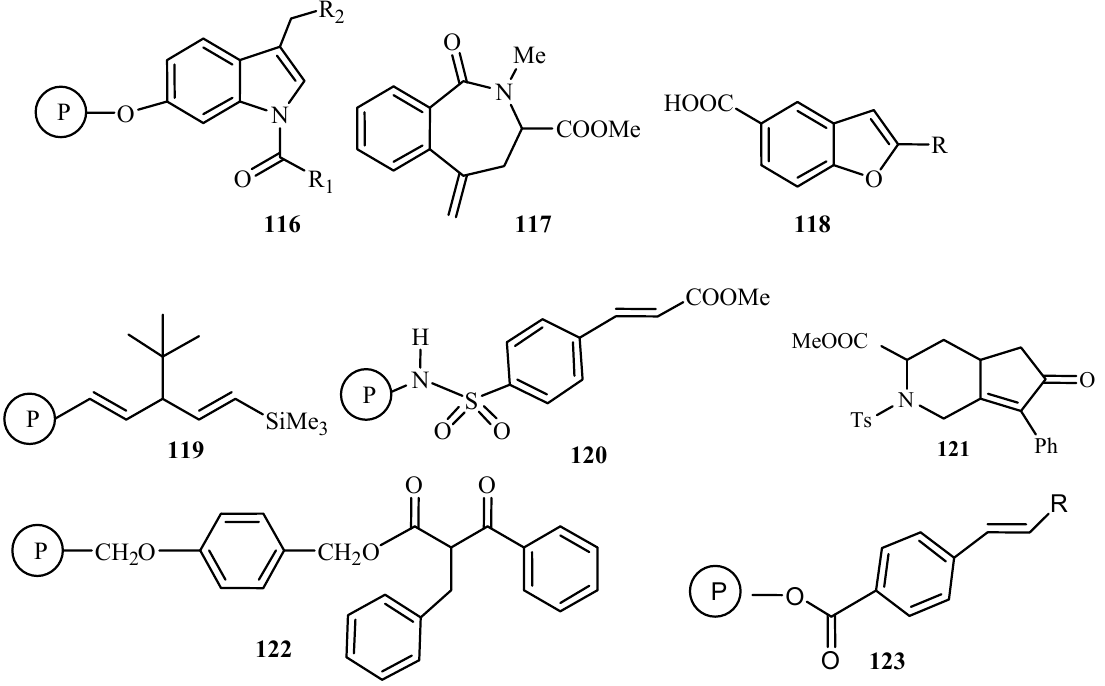
Figure 13. Molecule made via solid ‐ phase synthesis using Heck reaction reviewed by Franzén [27].